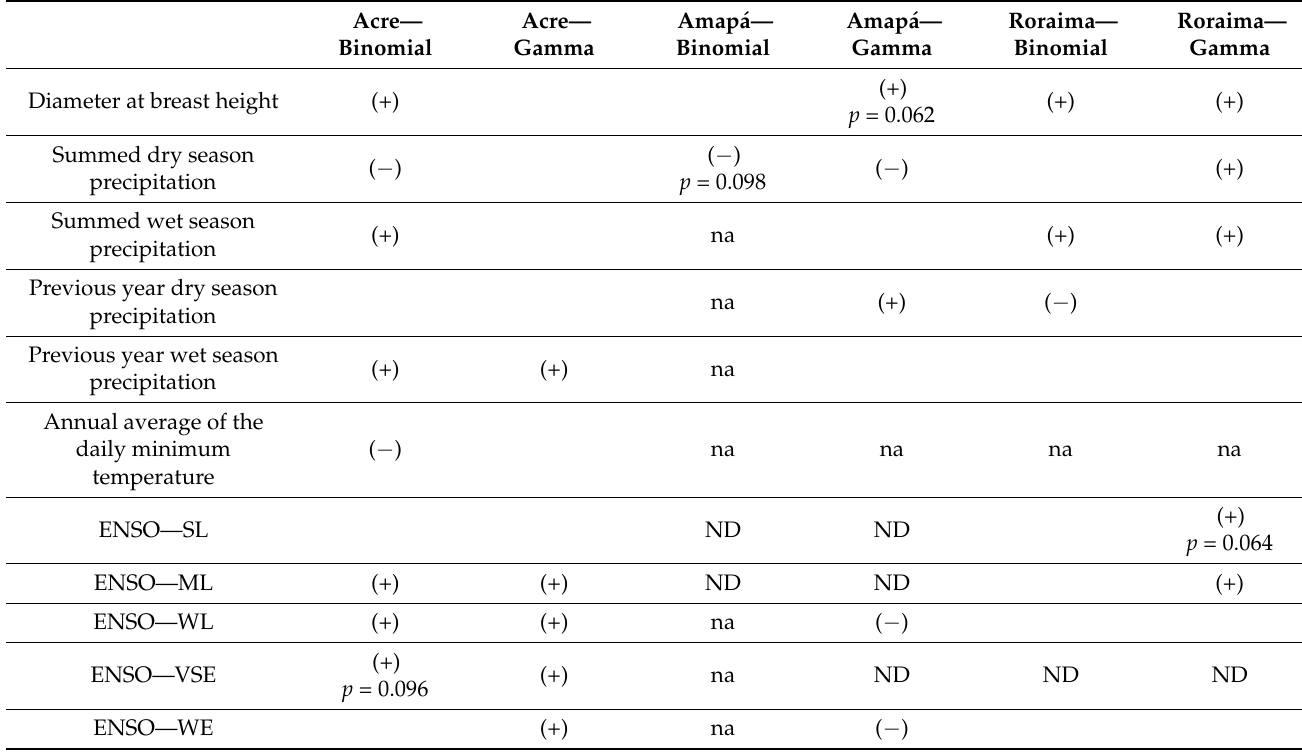
Table 2. Summarizes the results from best fit models for estimating the probability that the zero threshold is crossed, or whether C. guianensis individuals do (1) or do not (0) produce seeds a the Acre, Amap á , and Roraima, Brazil sites (Binomial). The presence of fruit production was modeled both (a) using individual climate variables and (b) the combination of climate variables associated with the El Nino Southern Oscillation. Year and tree ID were modeled as random factors. For the o. Results from best-fit models of the factors influencing the quantity of seed production per tree (g) at all three sites using a mixed model with a gamma distribution are also shown (Gamma). The quantity of fruit production was modeled both (a) using individual climate variables and (b) the combination of climate variables associated with the El Nino Southern Oscillation with year and individual tree (repeated measures) as random effects. Full models for each site can be seen in the Supplementary Materials. Positive effects are noted with a (+) and negative effects with a ( − ). Effects are significant at the p < 0.05 level unless a p -value is noted alongside the direction of the effect. Absence of significant effects are noted with blanks.